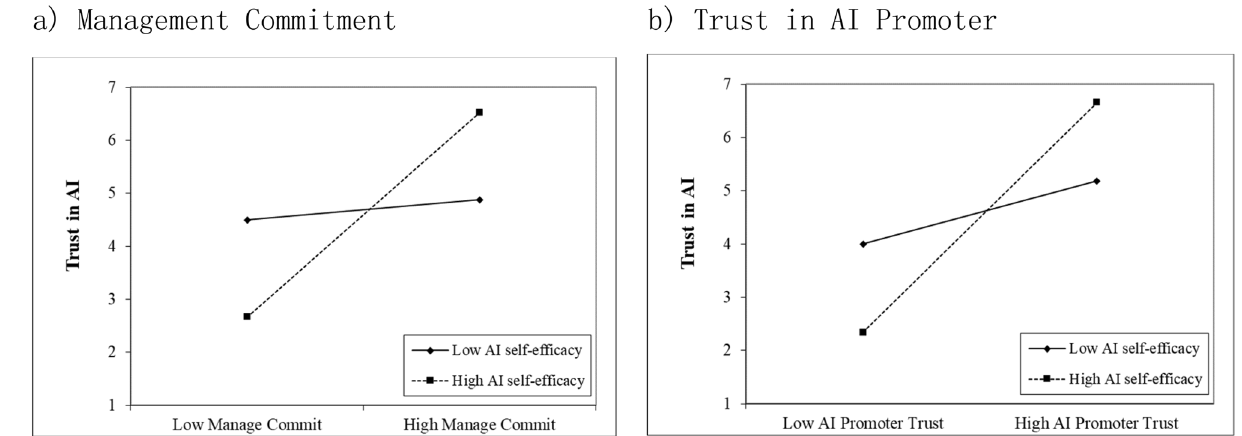
Figure 2. The moderating effect of AI self-efficacy on ( a ) management commitment and ( b ) trust in AI